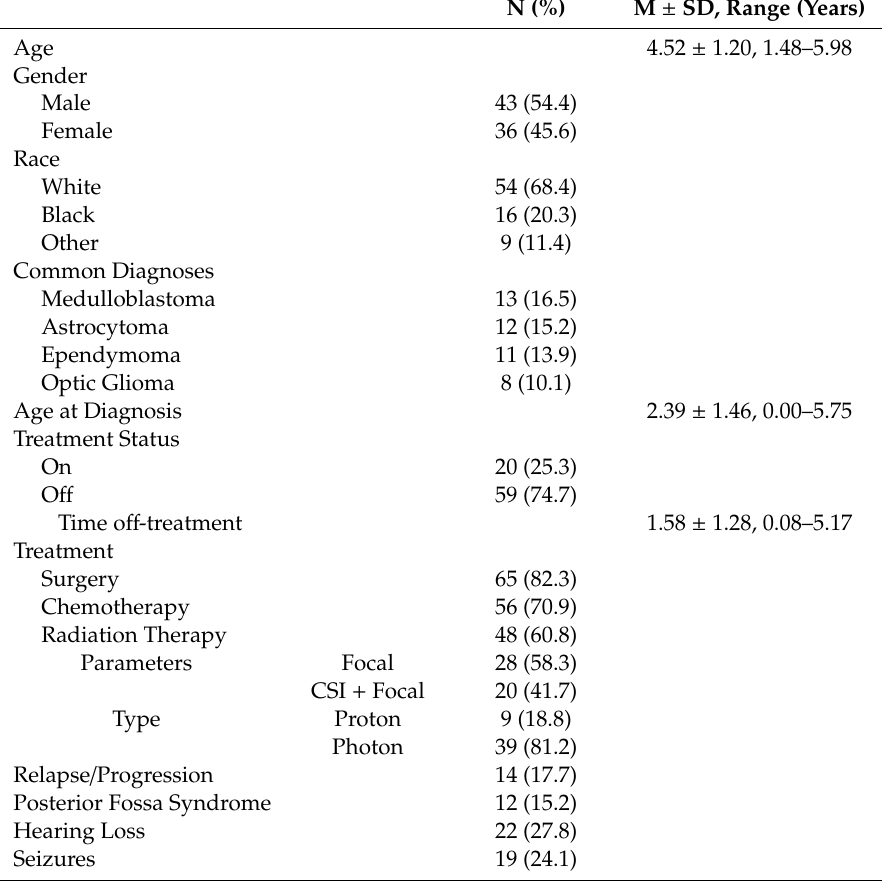
Table 1. Demographic and medical information (n =